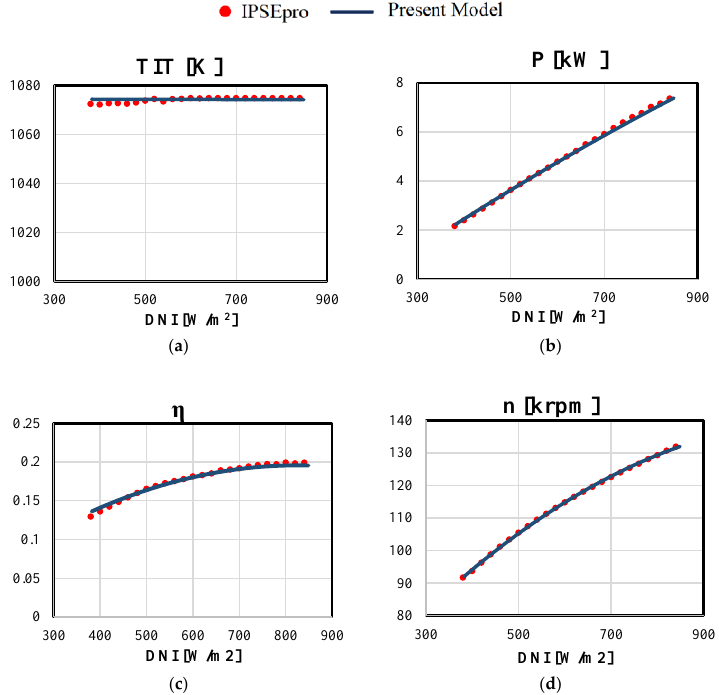
Figure 13. Plant off-design performance charts under variable DNI. ( a ) TIT; ( b ) output power; ( c ) efficiency; ( d ) rotational speed.